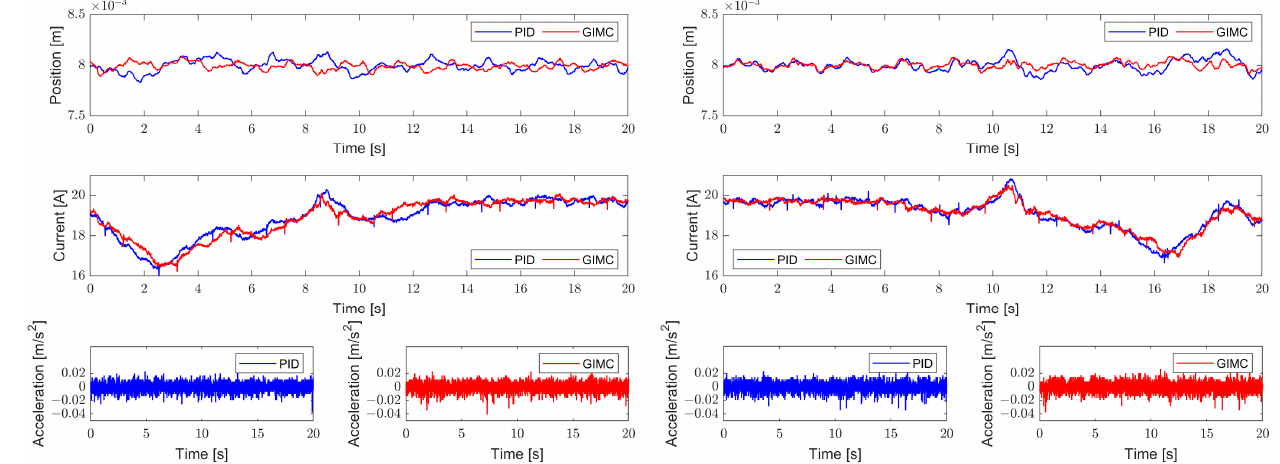
Figure 21. The experimental results in the single-bogie experimental platform. ( a ) From point A to point B; ( b ) from point B to point A.